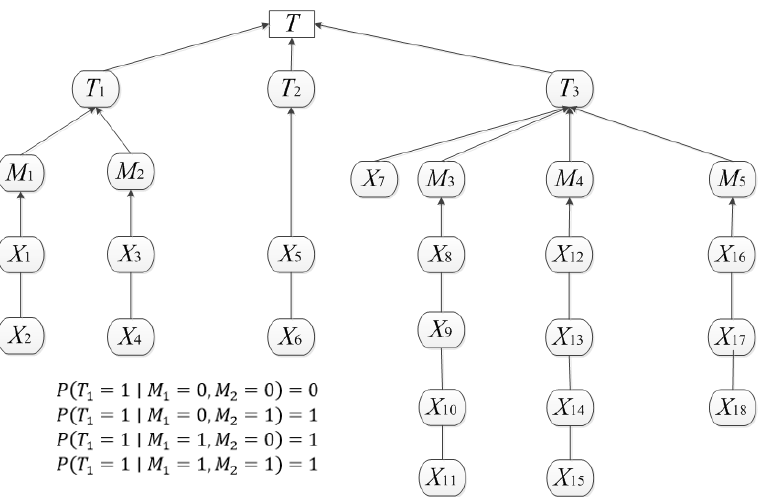
Figure 8. Topological structure of the Bayesian network of bottlenecks of bike-sharing travel.